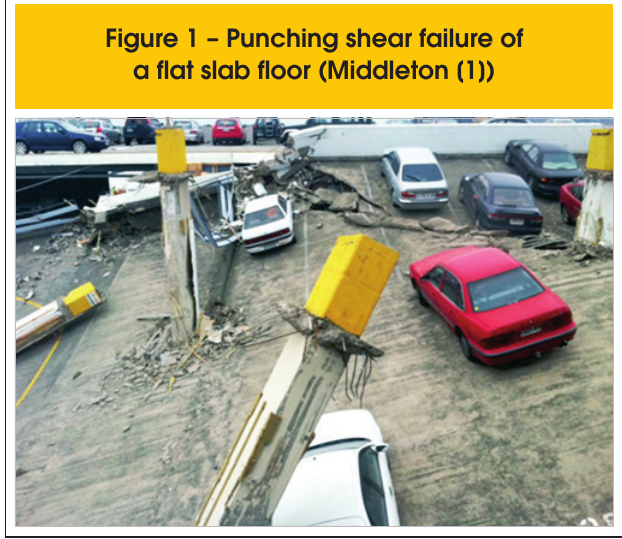
Figure 1 – Punching shear failure of a flat slab floor (Middleton